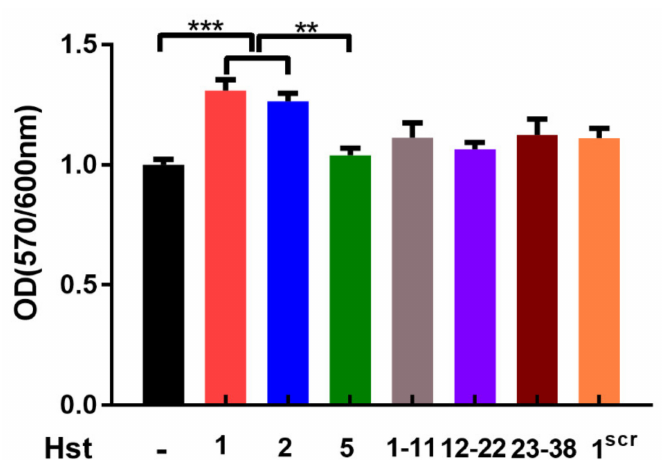
Figure 9. Graph depicting the e ff ects of Hst1, Hst2, Hst5, F-Hst1 1-11 , F-Hst1 12-22 and F-Hst1 scr on the cellular metabolic activity of HO1N1 human epithelial cells measured using PrestoBlue assay. The results showed that Hst1 and Hst2, but not other Hst1 variants, significantly enhanced cellular metabolic activity of HO1N1 epithelial cells in comparison with the control group (no Hsts). Data were